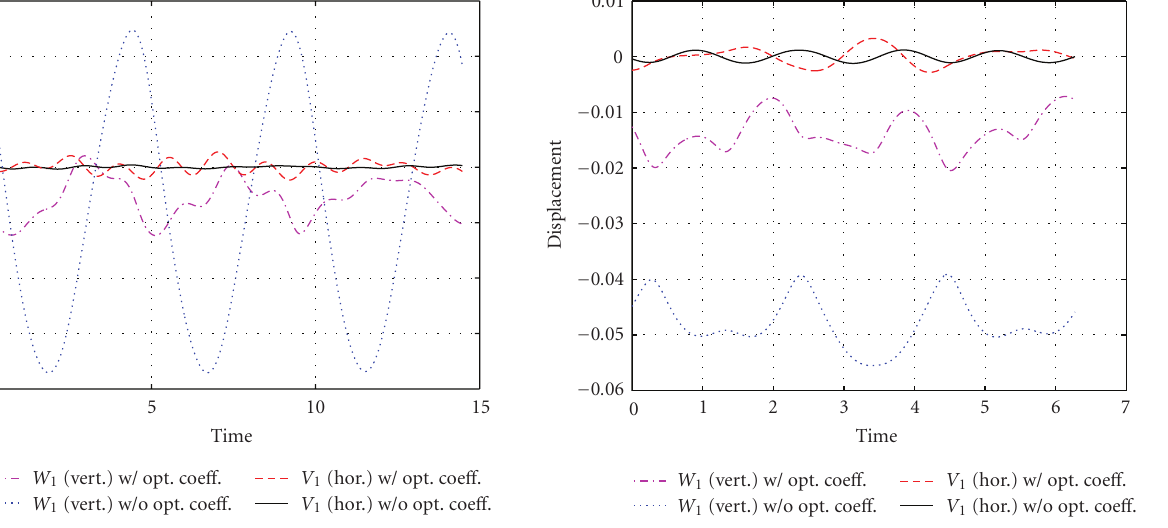
Figure 9: Response plots at Ω b = 1 . 3, bearing 1.